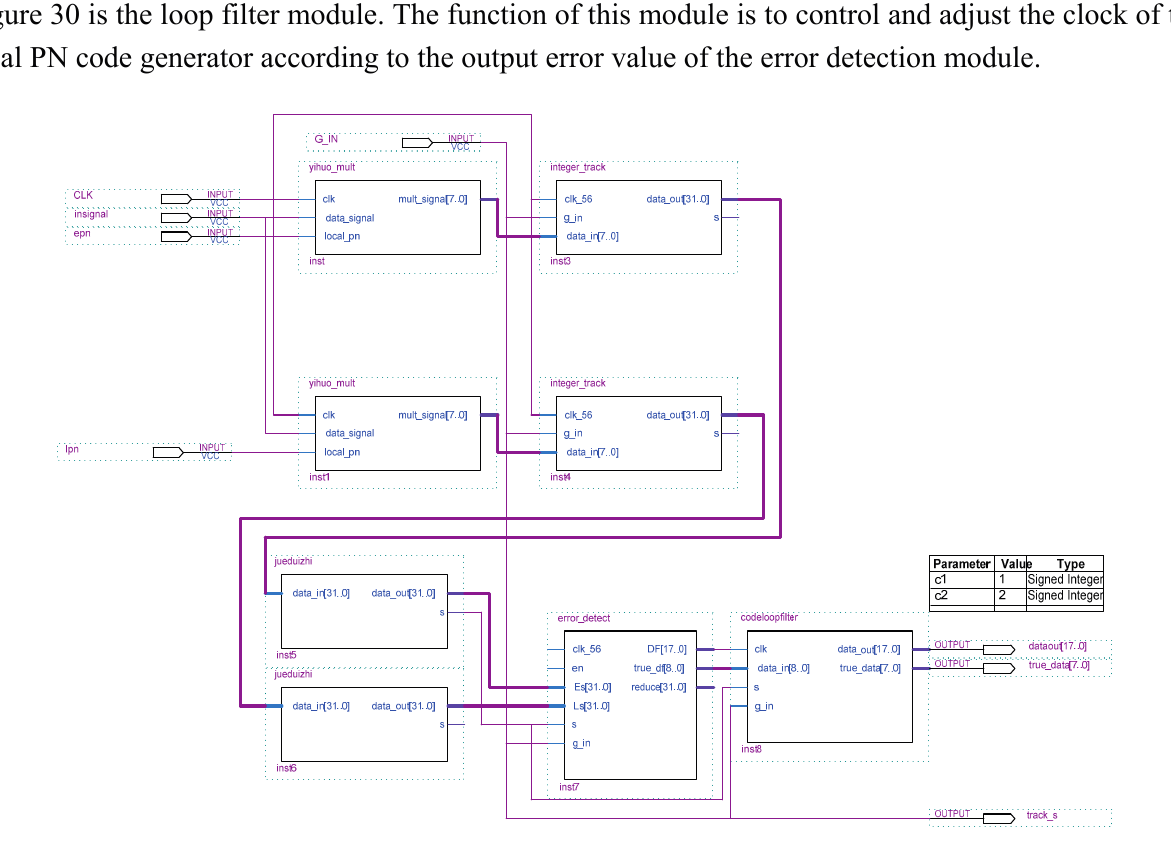
Figure 30. The top-level design of the code tracking